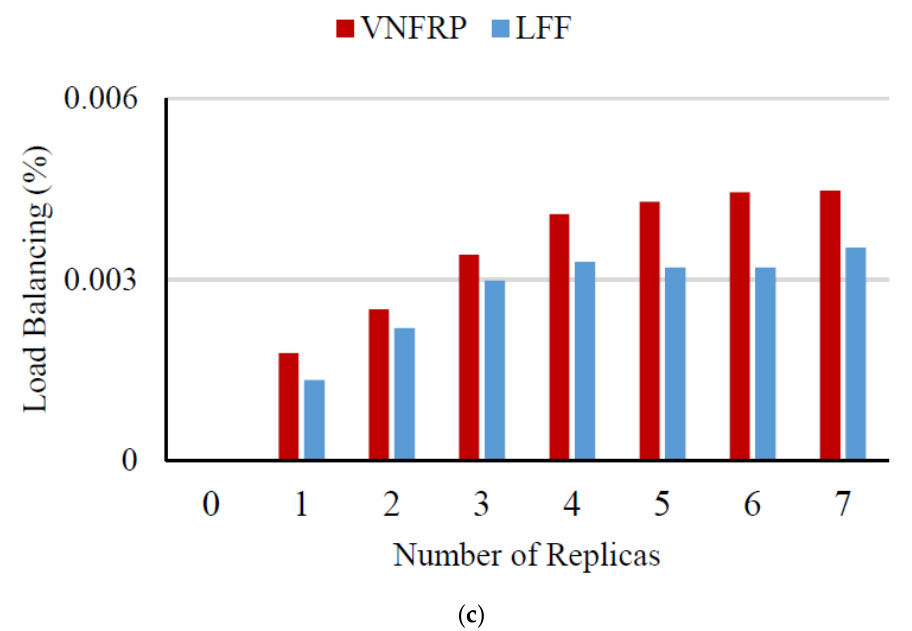
Figure 4. Load balancing when adopting the VNFRP algorithm and the corresponding values when adopting the LFF strategy: ( a ) Level 1, ( b ) Level 2, and ( c ) Level 3.